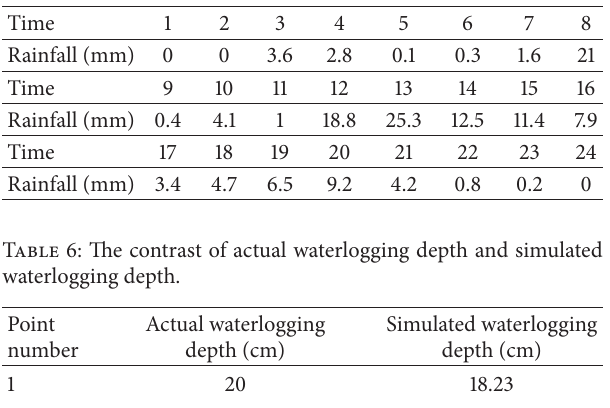
Figure 7: Distribution map of roughness determined according to Table 2. Table 5: The rainfall data of June 28, 2013, coming from the observation data.